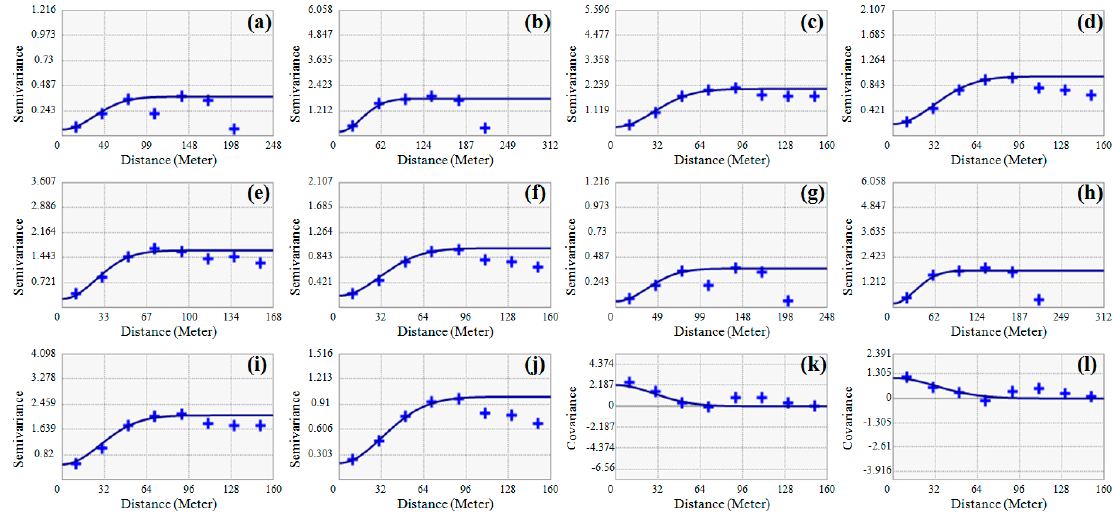
Figure 5. Results of variogram modeling: ( a , b ) copper and lead for approach 1, respectively; ( c , d ) copper and lead for approach 2, respectively; ( e , f ) copper and lead for approach 3, respectively; ( g , h ) copper and lead for approach 4 (primary), respectively; ( i , j ) copper and lead for approach 4 (secondary), respectively; and ( k , l ) copper and lead for approach 4 (cross variogram), respectively.